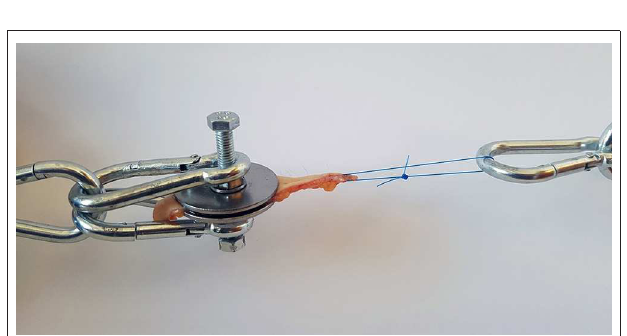
FIGURE 2 | Clamped skin sample with penetrating suture attached to the